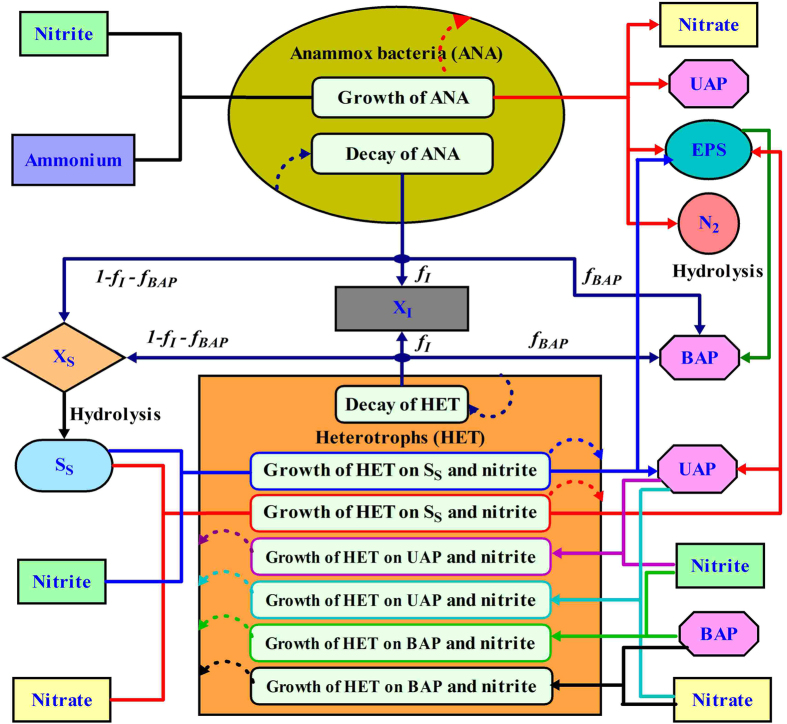
The substrate conversion and microbial interaction among ammonium (SNH4), nitrite (SNO2), nitrate (SNO3), readily biodegradable substrate (SS), anammox organisms (XANA), heterotrophic biomass (XHET), slowly biodegradable substrate (XS), residual inert biomass (XI), utilization-associated products (SUAP), biomass-associated products (SBAP), and extracellular polymeric substances (XEPS).